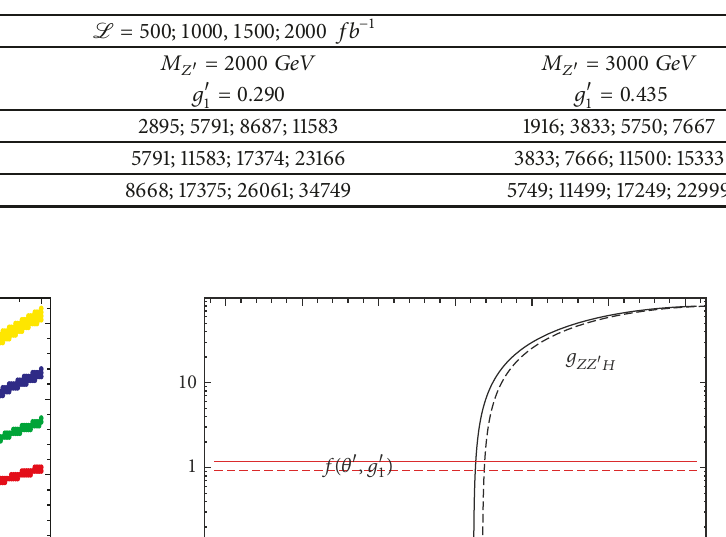
Table 3: Total productionof 𝑡𝑡ℎ inthe B-Lmodelfor 𝑀 푍 󸀠 = 1000,2000,3000 𝐺𝑒𝑉 , L = 500,1000,1500,2000 𝑓𝑏 −1 , 𝑀 ℎ = 125 𝐺𝑒𝑉 , 𝛼 = 𝜋/9 and 𝜃 耠 = 10 −3 .